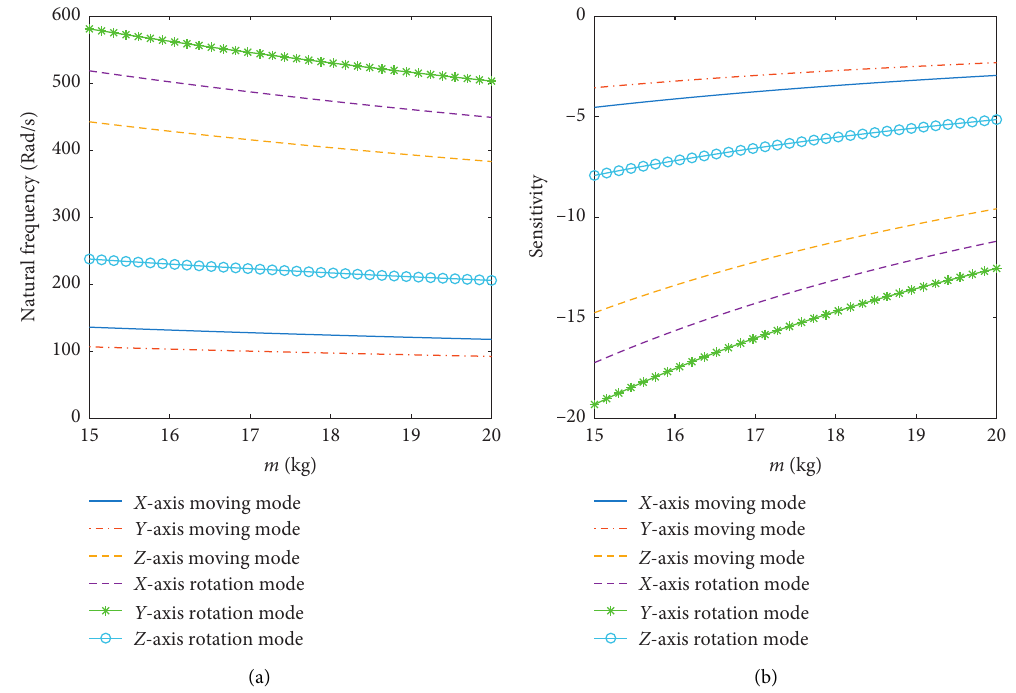
Figure 8: Curves of natural frequency and its sensitivity as a function of upper platform mass. (a) Natural frequency. (b) Sensitivity of natural frequency to upper platform mass.